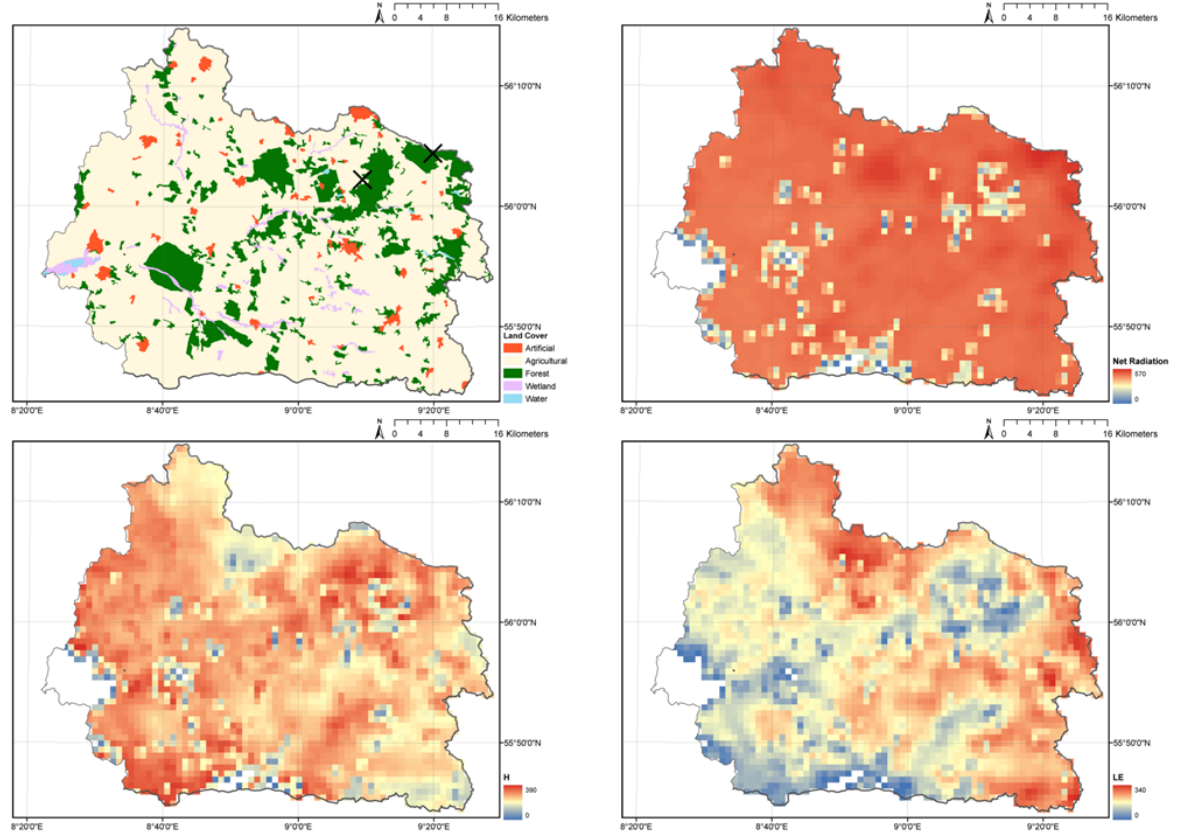
Fig. 11. Land cover classification with the location of the two HOBE flux tower sites marked as Xs (top left) and instantaneous net radiation (top right), sensible (bottom left), and latent (bottom right) heat fluxes over the Skjern River catchment on 20 April 2009 around noon, in W m − 2